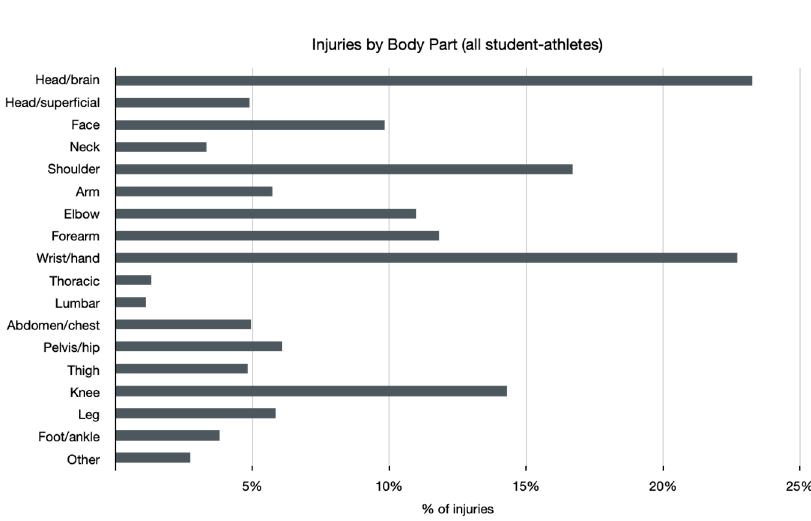
Figure 1. Proportion of student athlete injuries by body part, n = 1677 injury events and 2587 injuries. The most commonly injured body parts were head/brain (i.e., concussion or possible concussion, 23.3%), wrist/hand (22.7%), and shoulder (16.7%).